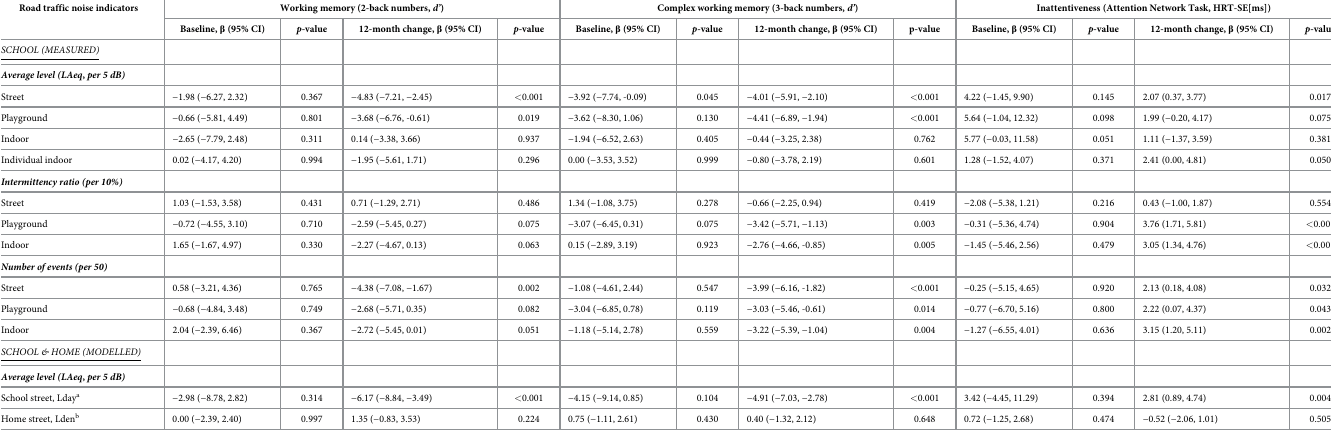
Table 3. Estimated effect ( β ) and 95% confidence intervals (95% CI) in working memory outcomes and inattentiveness at baseline and their 12-month change in association to school and home exposure to road traffic noise ( n = 2,680 children, 9,984